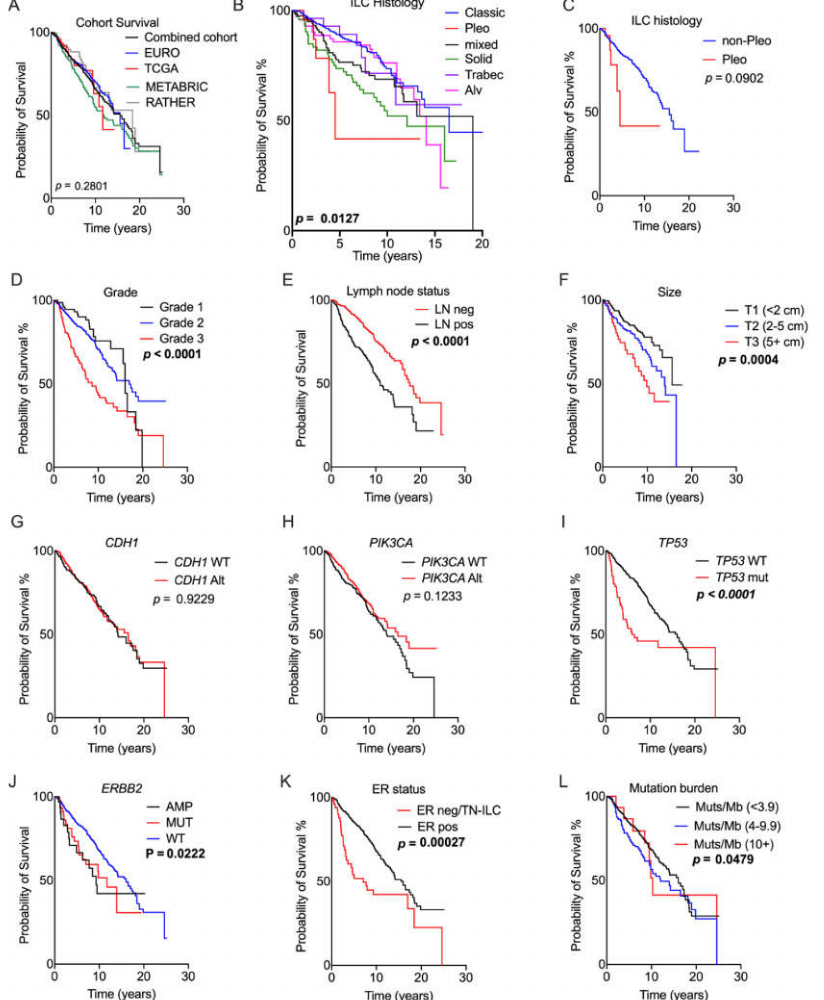
Figure 2. Association of genomic and pathology features with prognosis. Kaplan–Meier curves measuring survival associations of the following features: ( A ) overall survival; ( B ) ILC histology; ( C ) pleomorphic histotype; ( D ) grade; ( E ) lymph node status; ( F ) tumour size; ( G ) CDH1 gene status; ( H ) PIK3CA gene status; ( I ) TP53 gene status; ( J ) ERBB2 gene status; ( K ) ER status; and ( L ) tumour mutation burden expressed as mutations/Mb. The RATHER data were included for this analysis with the exception of ( L ). Abbreviations: Alt = any genetic alteration; Alv = alveolar; AMP = amplification; LN = lymph node; MUT = mutation; neg = negative; pleo = pleomorphic; pos = positive; TN-ILC = triple-negative ILC; trabec = trabecular; and WT = wild type. Significant p -values (log-rank test) are noted in bold.